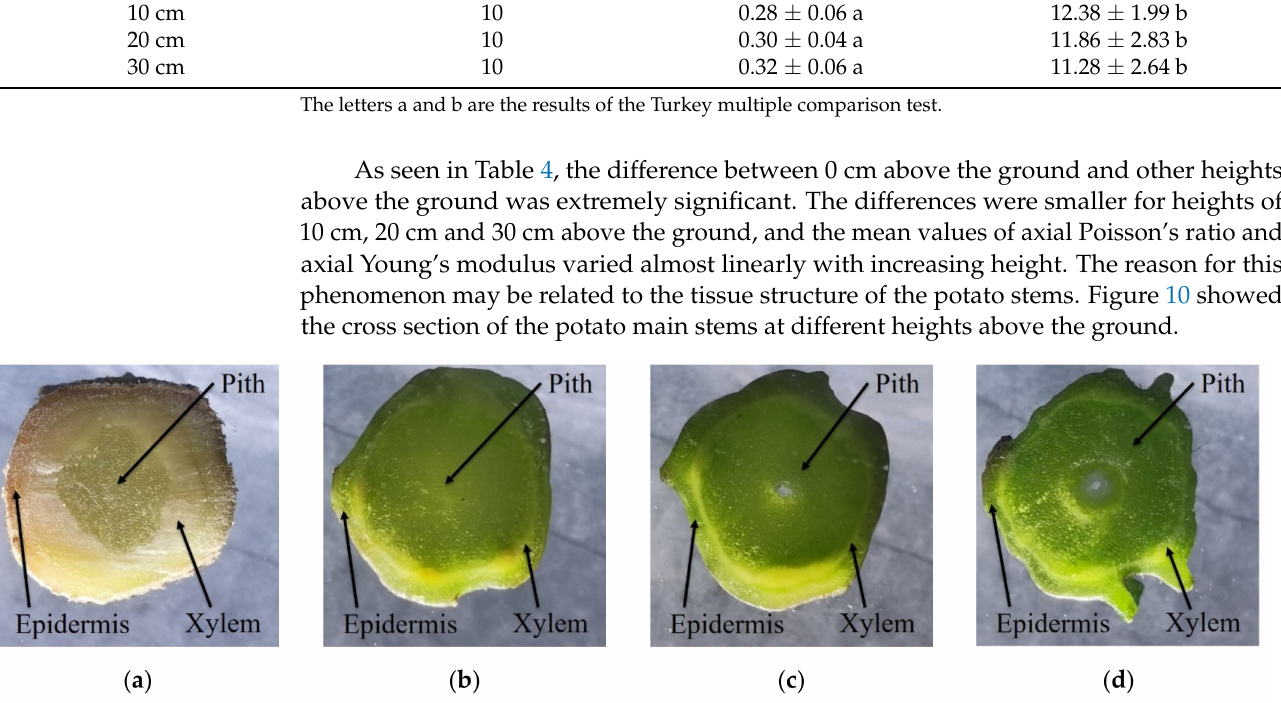
Figure 10. The cross section of the potato main stems at different heights above the ground ( a ) 0 cm; ( b ) 10 cm; ( c ) 20 cm; ( d ) 30